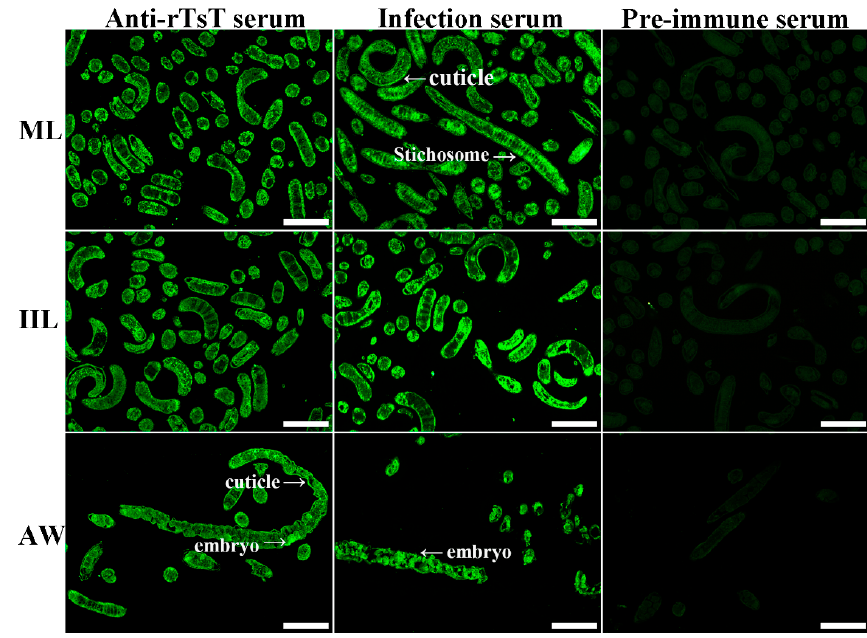
staining was localized at the epicuticle of only 5- and 6- day adult worms. Pre-immune serum did not identify any cuticle of all lifecycle stages of T. spiralis . Bar, 50 µm.